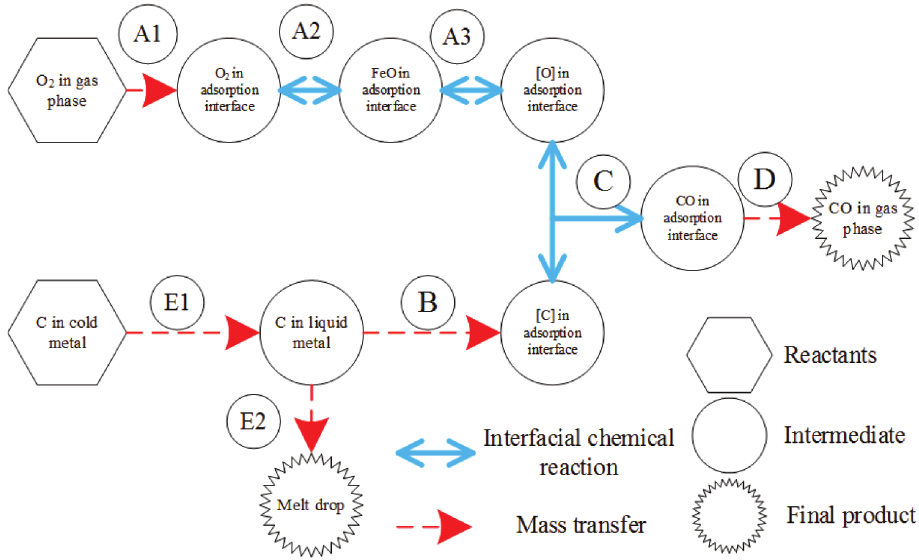
Fig. 3: Steps in the melting and decarburization